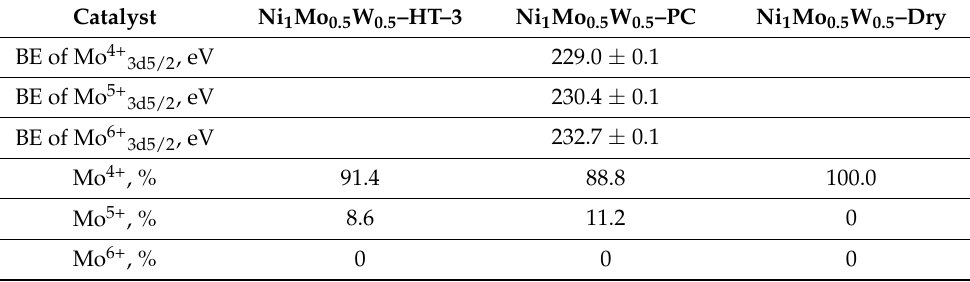
Figure 10. XPS spectra of the Ni 1 Mo 0.5 W 0.5 –HT–3, Ni 1 Mo 0.5 W 0.5 –PC and Ni 1 Mo 0.5 W 0.5 –dry catalyst precursors recorded after catalytic tests. Table 2. XPS data for Ni 1 Mo 0.5 W 0.5 –HT–3, Ni 1 Mo 0.5 W 0.5 –PC and Ni 1 Mo 0.5 W 0.5